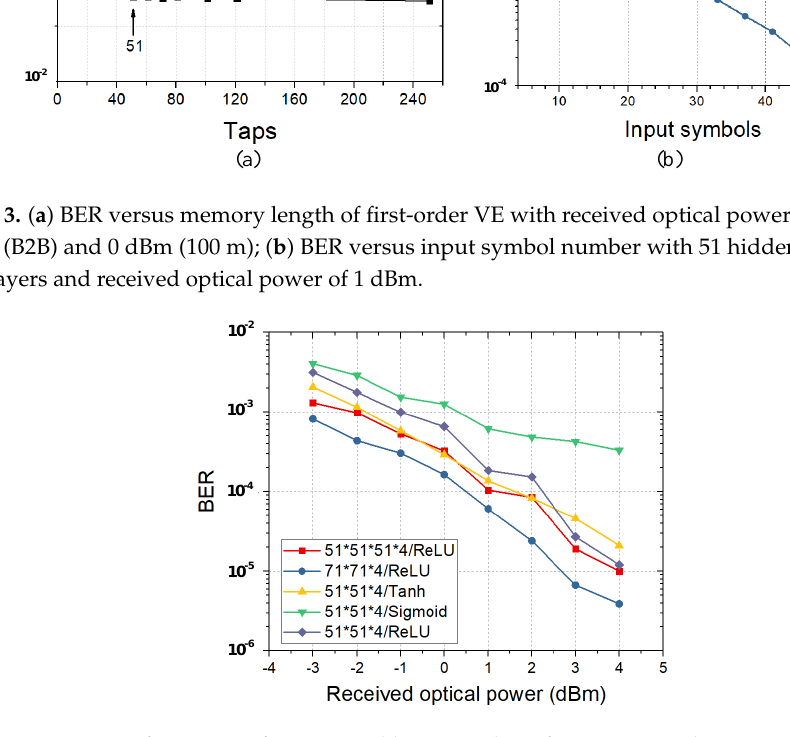
Figure 4. Impact of activation function and layer number of NNE on equalization